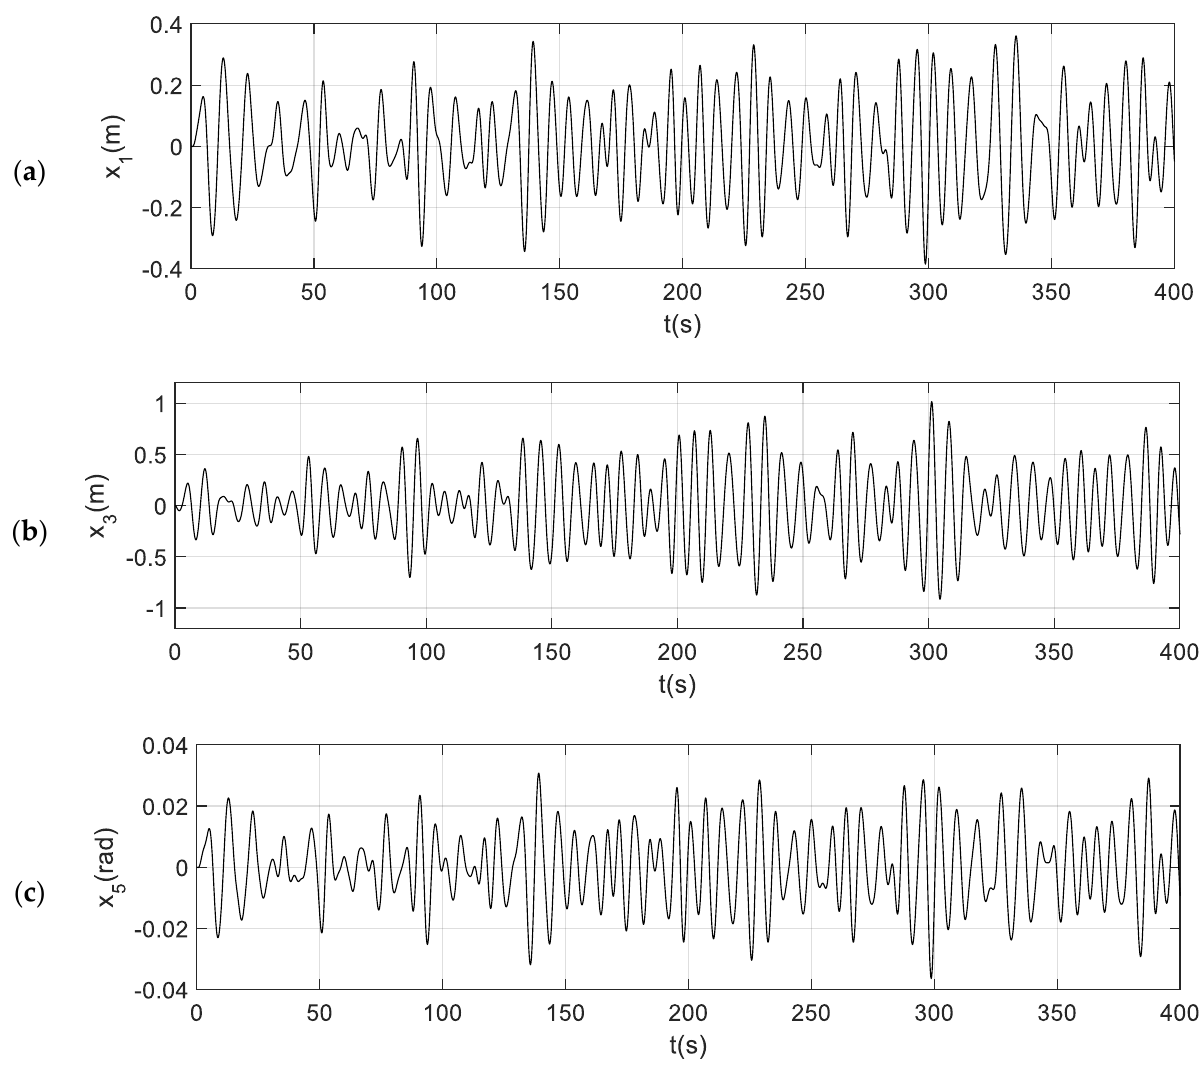
Figure 14. Time histories of the structure motions. ( a ) surge; ( b ) heave; ( c ) pitch.